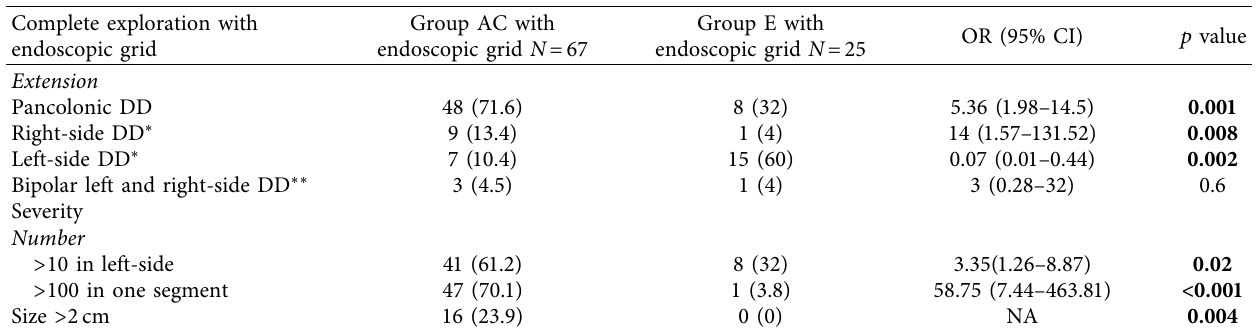
Table 3: Complete exploration of the colon in African Caribbean and European patients using a dedicated endoscopic